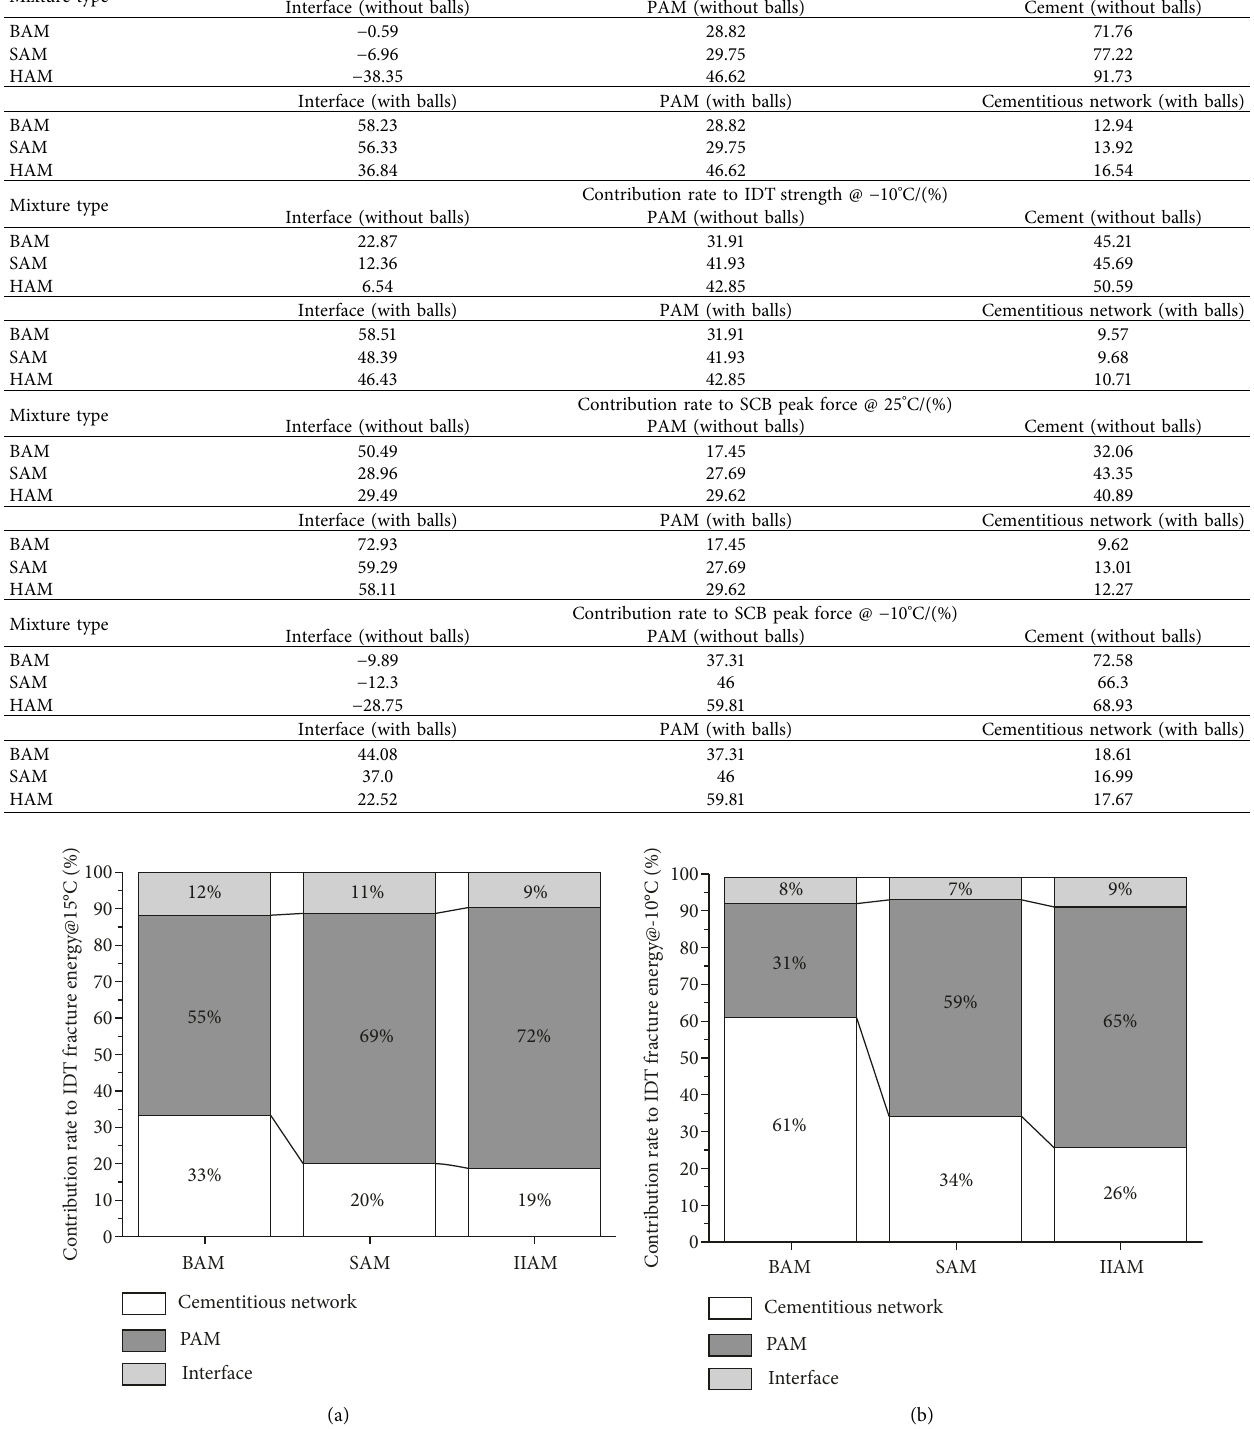
Figure 16: Contribution rates to IDT fracture energy. (a) 15 ° C. (b) − 10 °